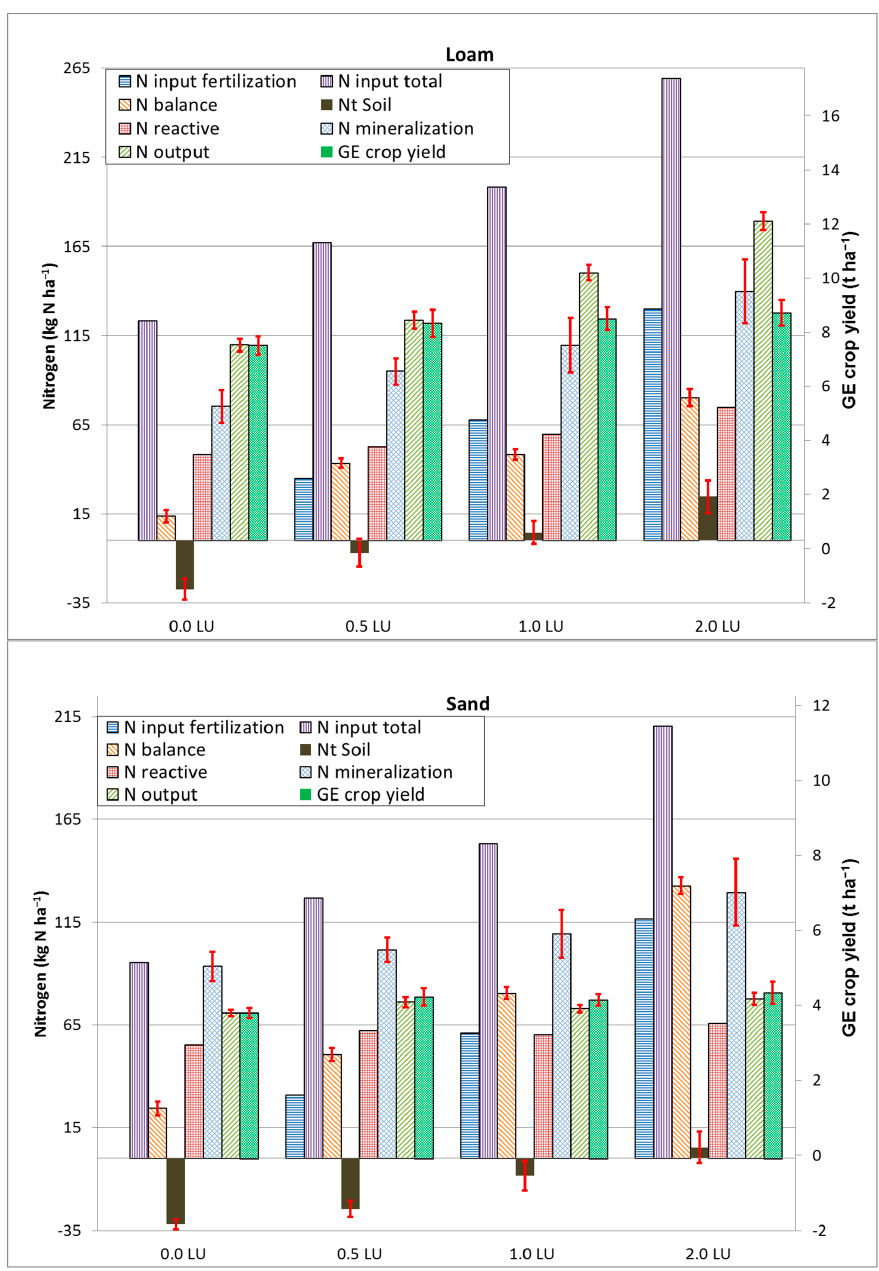
Figure 1. Changes in some balance criteria, mineralization and reactive N, and GE-yield as a function of four intensity levels (in LU ha − 1 ) from long-term experiments on loamy ( above ) and sandy soils ( below ) in absolute values and standard